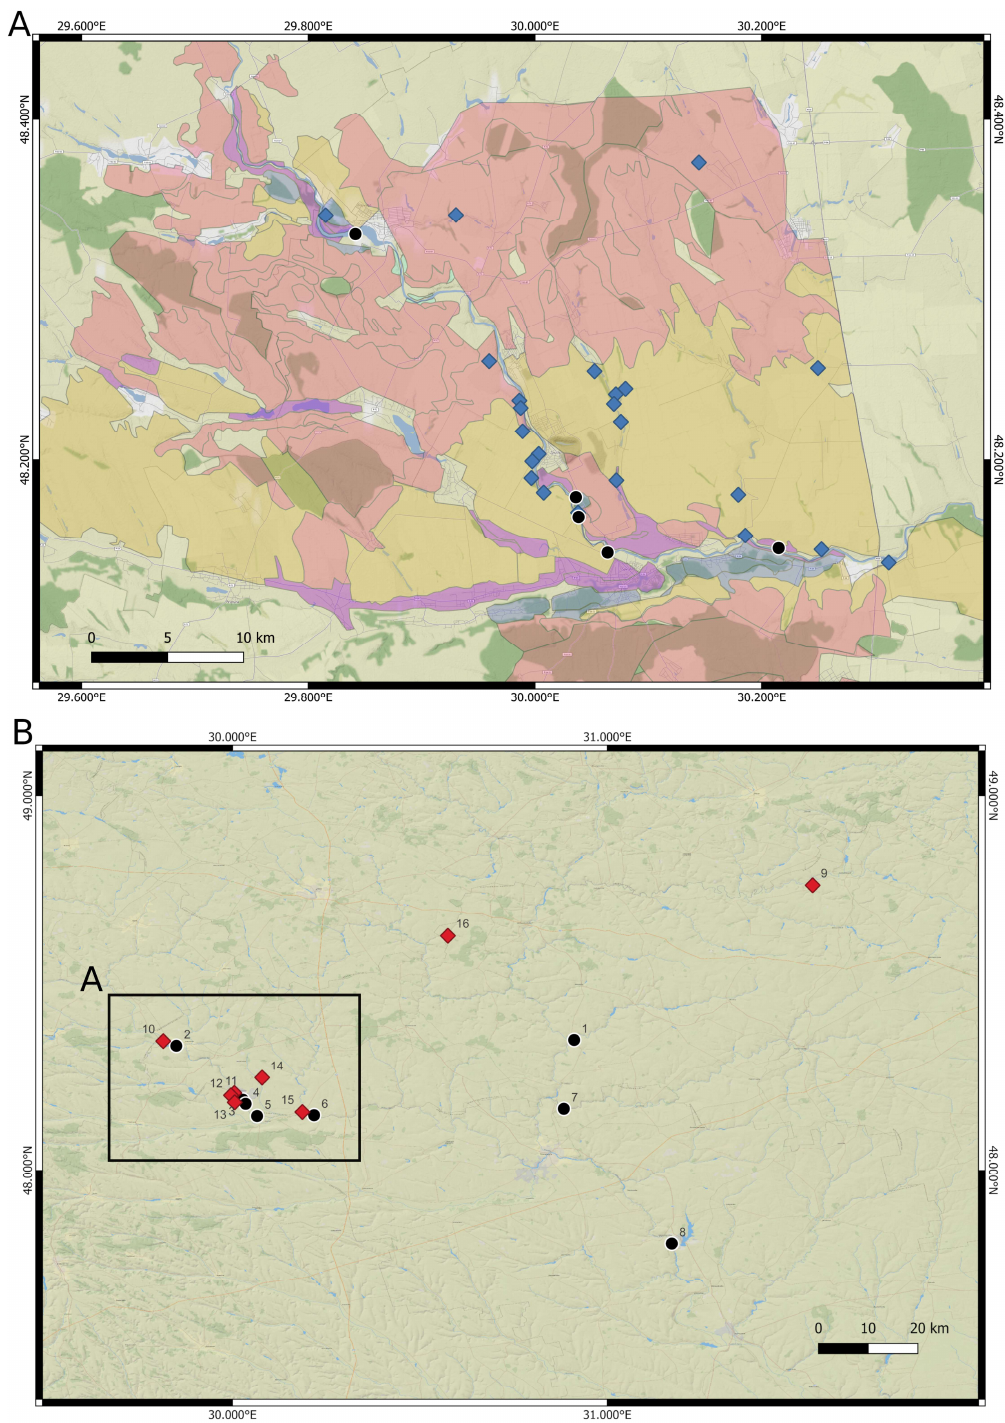
Figure 2. ( A ): An example of modern soils cover in the middle Southern Buh. Diamonds—early farming sites, circles—hunter-gatherers’ sites. Yellow areas—chernozems, reddish—forest soils, purple—meadow soils, blue—sands. ( B ): The sites of hunter-gatherers (black dots) and early farmers (red diamonds) in the Southern Buh catchment. 1—Dobrianka 1 and 3, 2—Haivoron-Polizhok, 3—Zavallia, 4—Zhakchyk, 5—Savran, 6—Melnychna Krucha, 7—Mykolyna Broiaka, 8—Gard